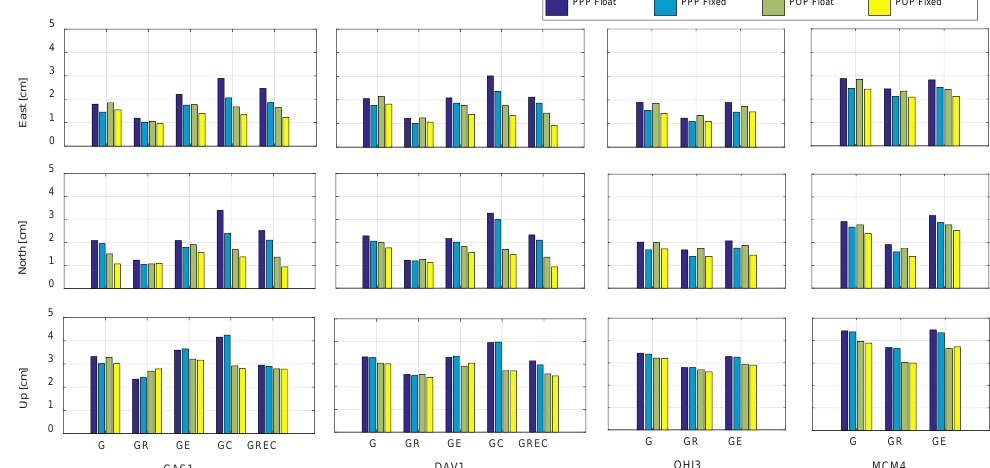
Figure 6. The average RMS values of kinematic PPP and POP solutions after converged for stations CAS1, DAV1, OHI3 and MCM4 with different types of observations in the east, north and up components. For each day, the RMS values are calculated for each type of solutions, i.e., the PPP float with GPS observations in the east component, with reference to the IGS nominal position. Then the average RMS values are obtained over 14 days.